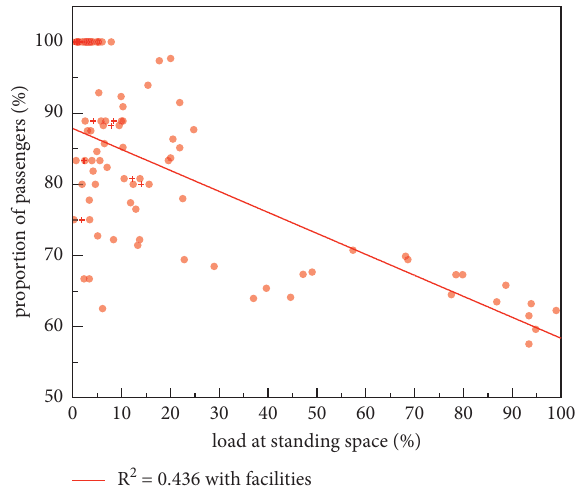
Figure 8: Changes in the proportion of passengers with